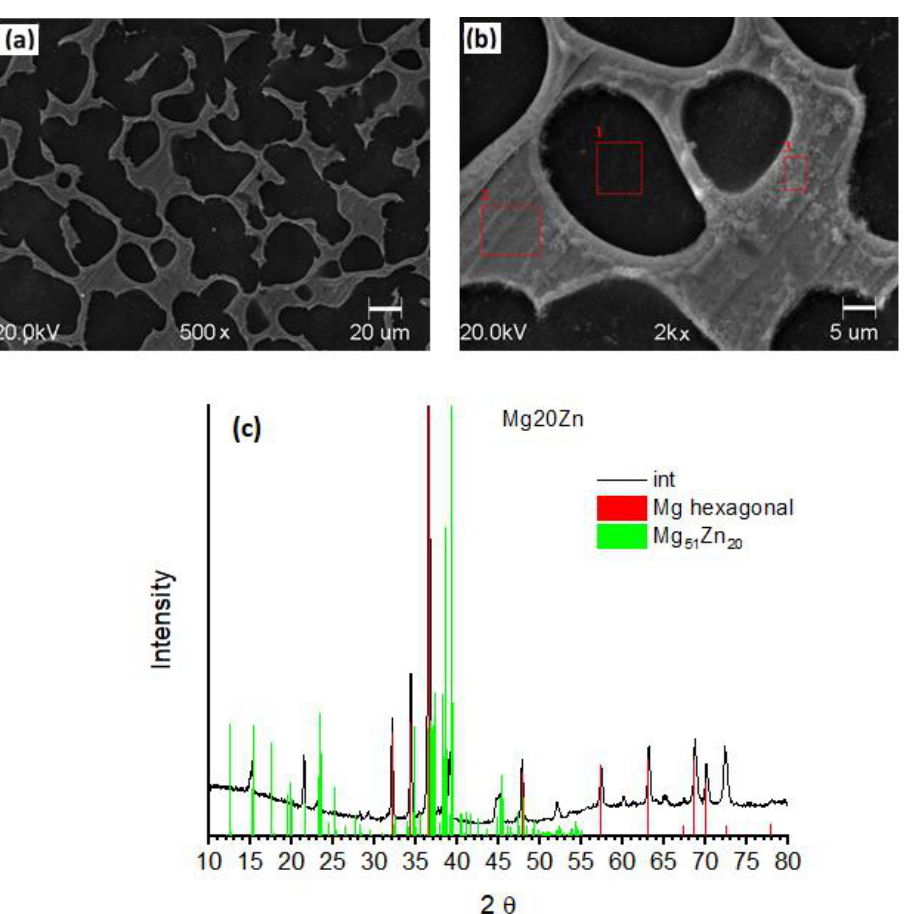
Figure 1. ( a , b ) SEM images of the Mg20Zn alloy after mechanical polishing. ( c ) XRD diffractogramm of the Mg20Zn alloy. Theoretical position of peaks related to α-Mg hexagonal (red bars) and Mg 51 Zn 20 intermetallic (green bars) phases are reported.